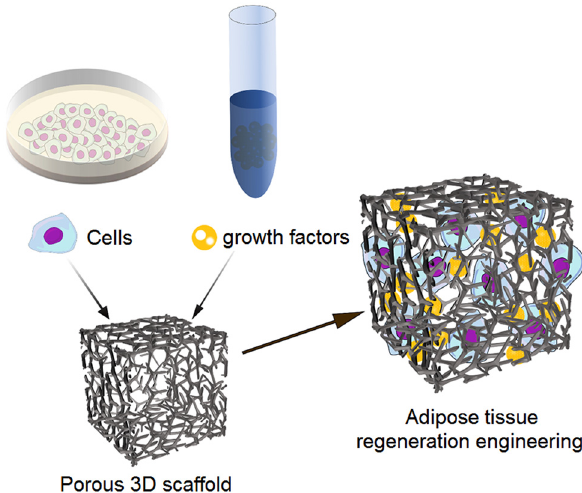
Figure 1: Cells, growth factors, and porous sca ff olds constitute the adipose tissue regeneration